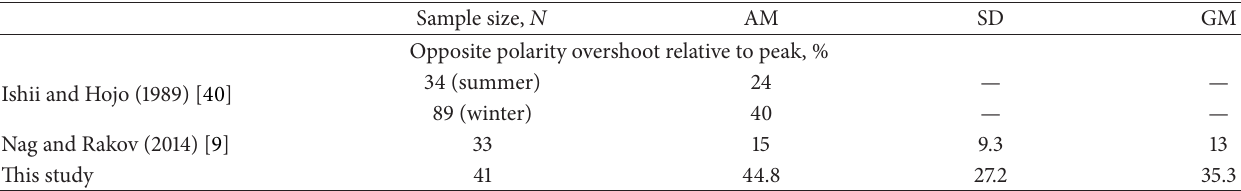
Table 8: Comparative values of key parameters in per unit (values measured in Malaysia are made as bases).